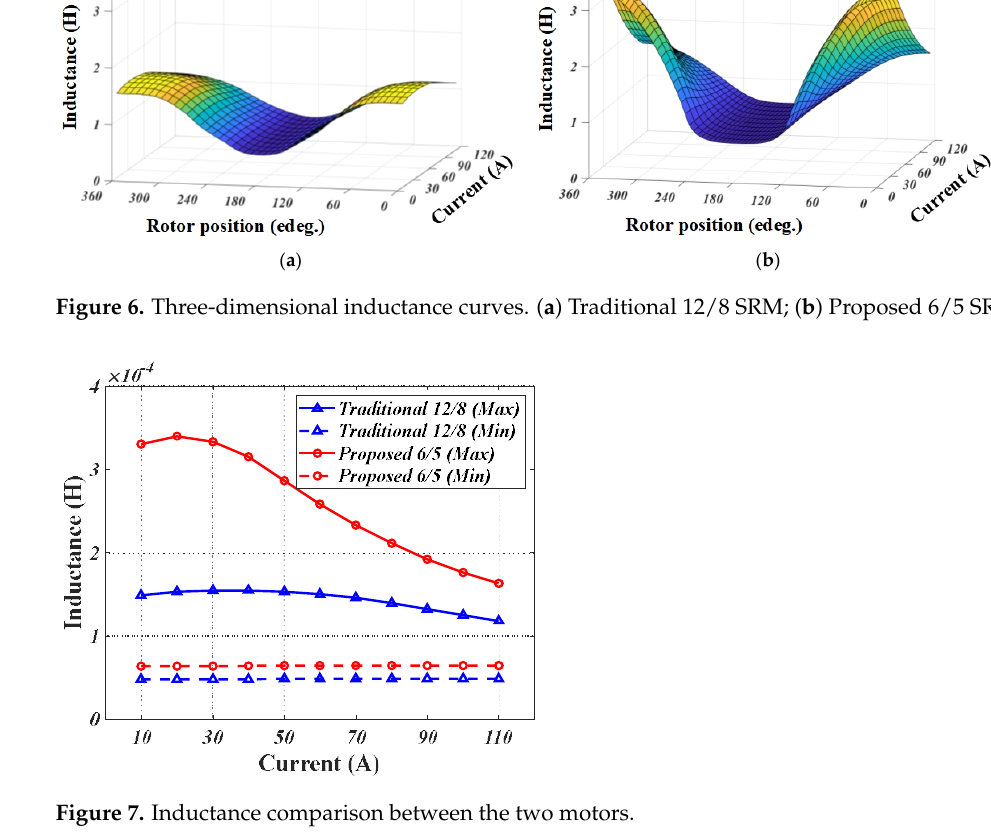
Figure 7. Inductance comparison between the two motors.